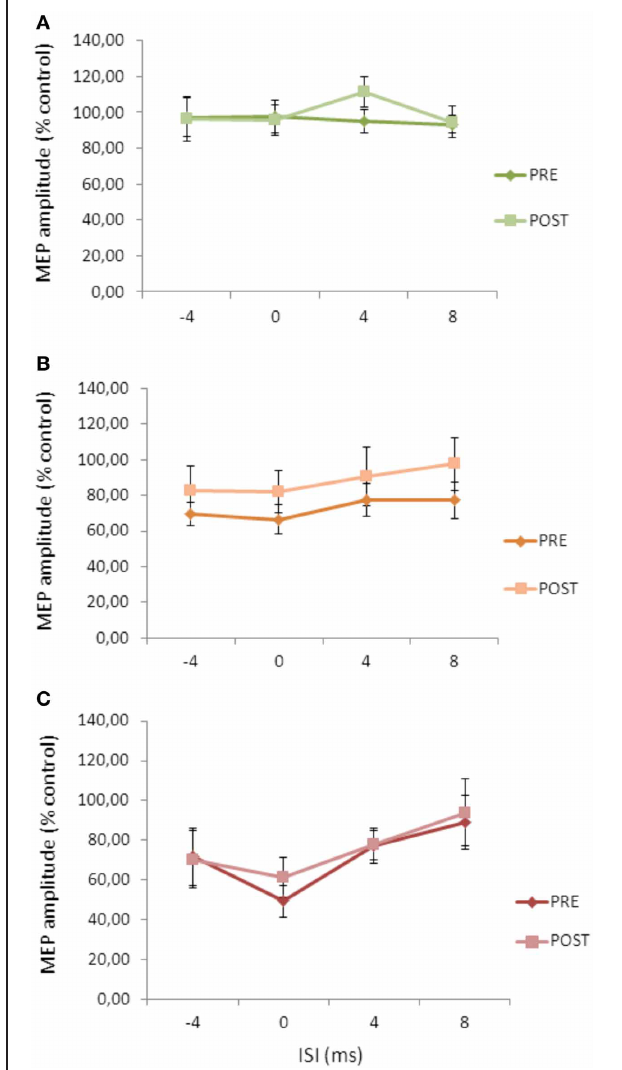
FIGURE 5 | Effects of cerebellar cTBS on SLAI applied with different intensities of peripheral nerve stimulation in healthy subjects (A) = 100%; (B) = 200%; (C) = 300% of the sensory threshold. Error bars indicate standard deviations. The size of MEPs is expressed as a percentage of the MEP evoked by magnetic stimulation alone. Error bars indicate mean standard errors.